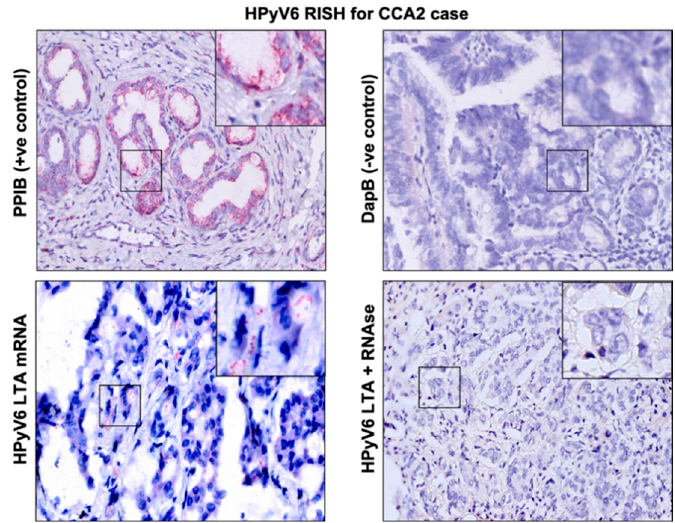
Figure 3. Detection of HPyV6 on the transcriptional level in FFPE CCA tissue by RNA-ISH, the CCA2 patient tissue section was hybridized with 20 sets labeled probes to detect HPyV6 LTAg mRNA using RNAscope RNA in situ hybridization assay. Additionally, FFPE hybridized with both the bacterial gene (DapB) as a negative control and the housekeeping gene (PPIB) as a positive control. Positive red signals were detected using fast red chromogen. HPyV6 LTA transcript seen as red signals in CCA and hepatocytes. No HPyV6 RNA was seen when the tissue was treated with RNAse, nuclei were counterstained with hematoxylin. The images were taken at 200x magnification, a black square area was magnified 6x in the top right corner of each figure.